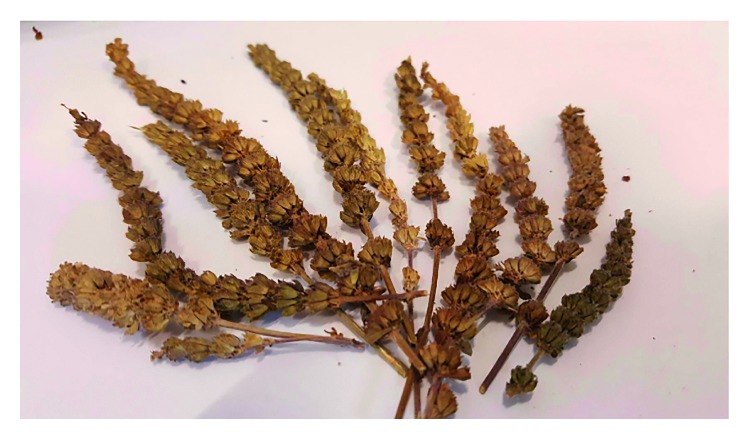
Dried terminal flower spike samples of Nepeta tenuifolia.